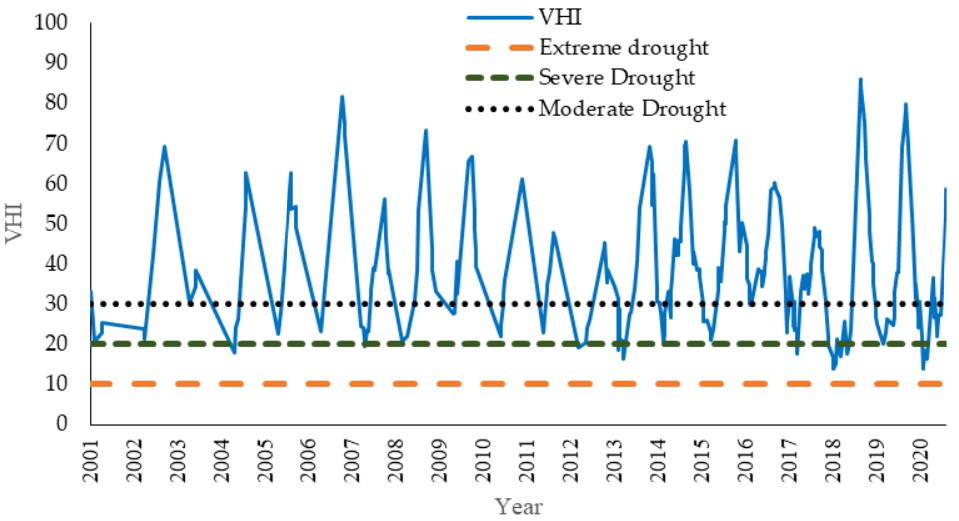
Figure 9. Time series plot of VHI in Al-Lith watershed extracted using Google Earth Engine and Landsat Satellite datasets. Table 4. Minimum, Maximum, and Mean values of VCI, TCI, and VHI